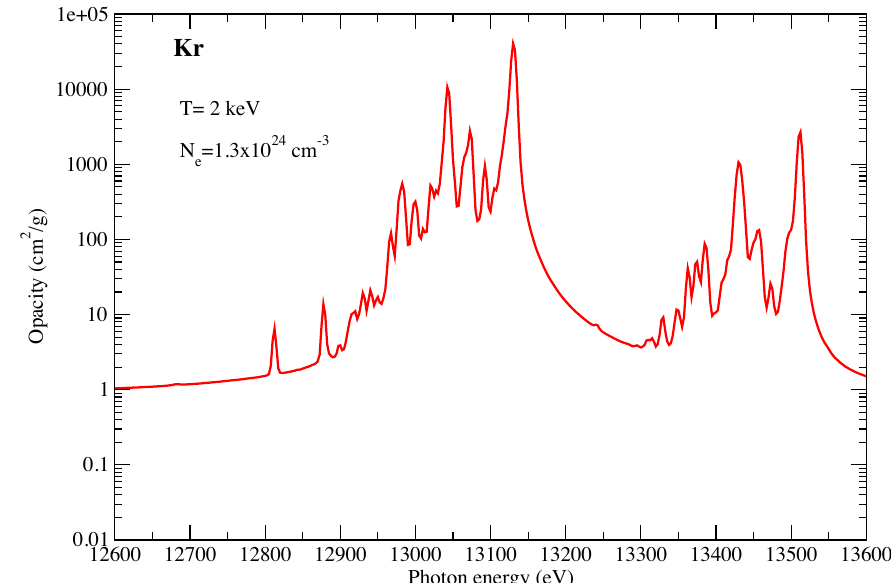
Figure 5. The opacity of Kr at a temperature of 2 keV and an electron density of 1.3 × 10 24 cm − 3